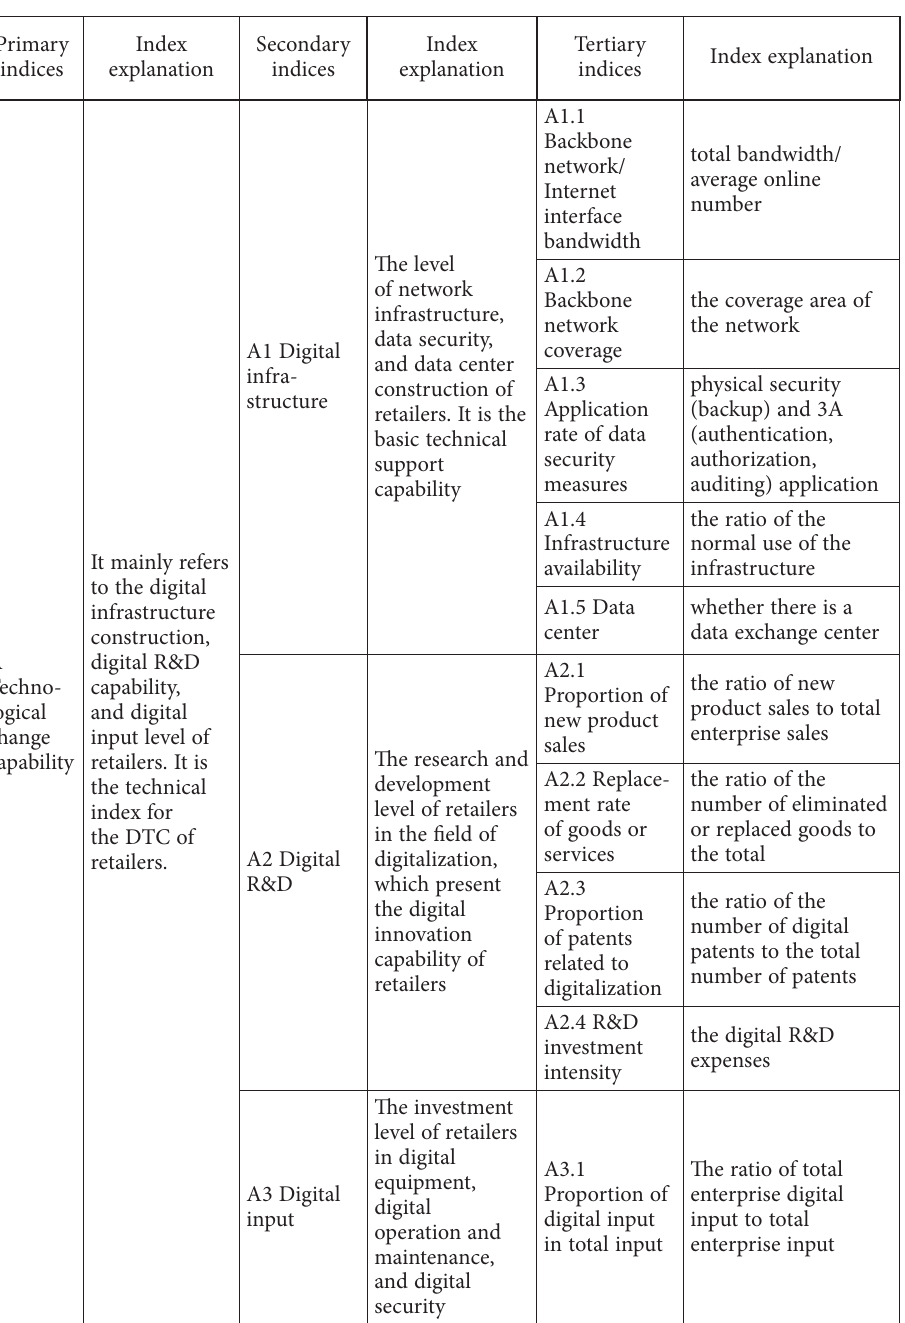
Table 9. Index system for retailer’s DTC Primary